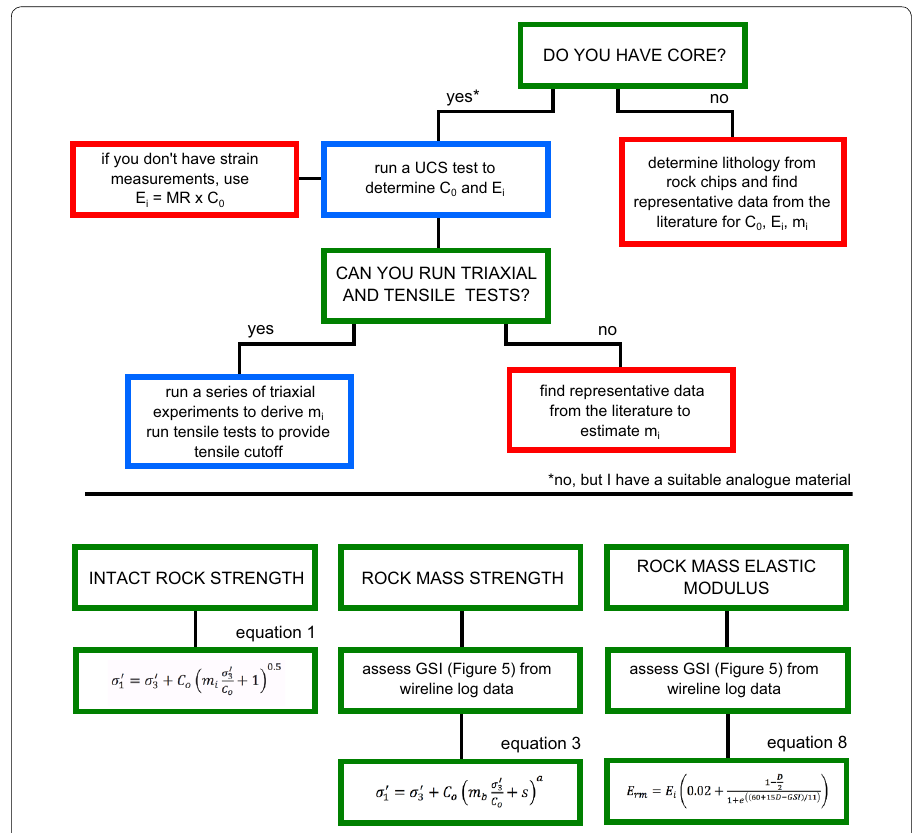
Fig. 10 Flow chart for determining in situ strength (intact and rock mass strength) and rock mass elastic modulus depending on available data. Blue boxes show the recommended